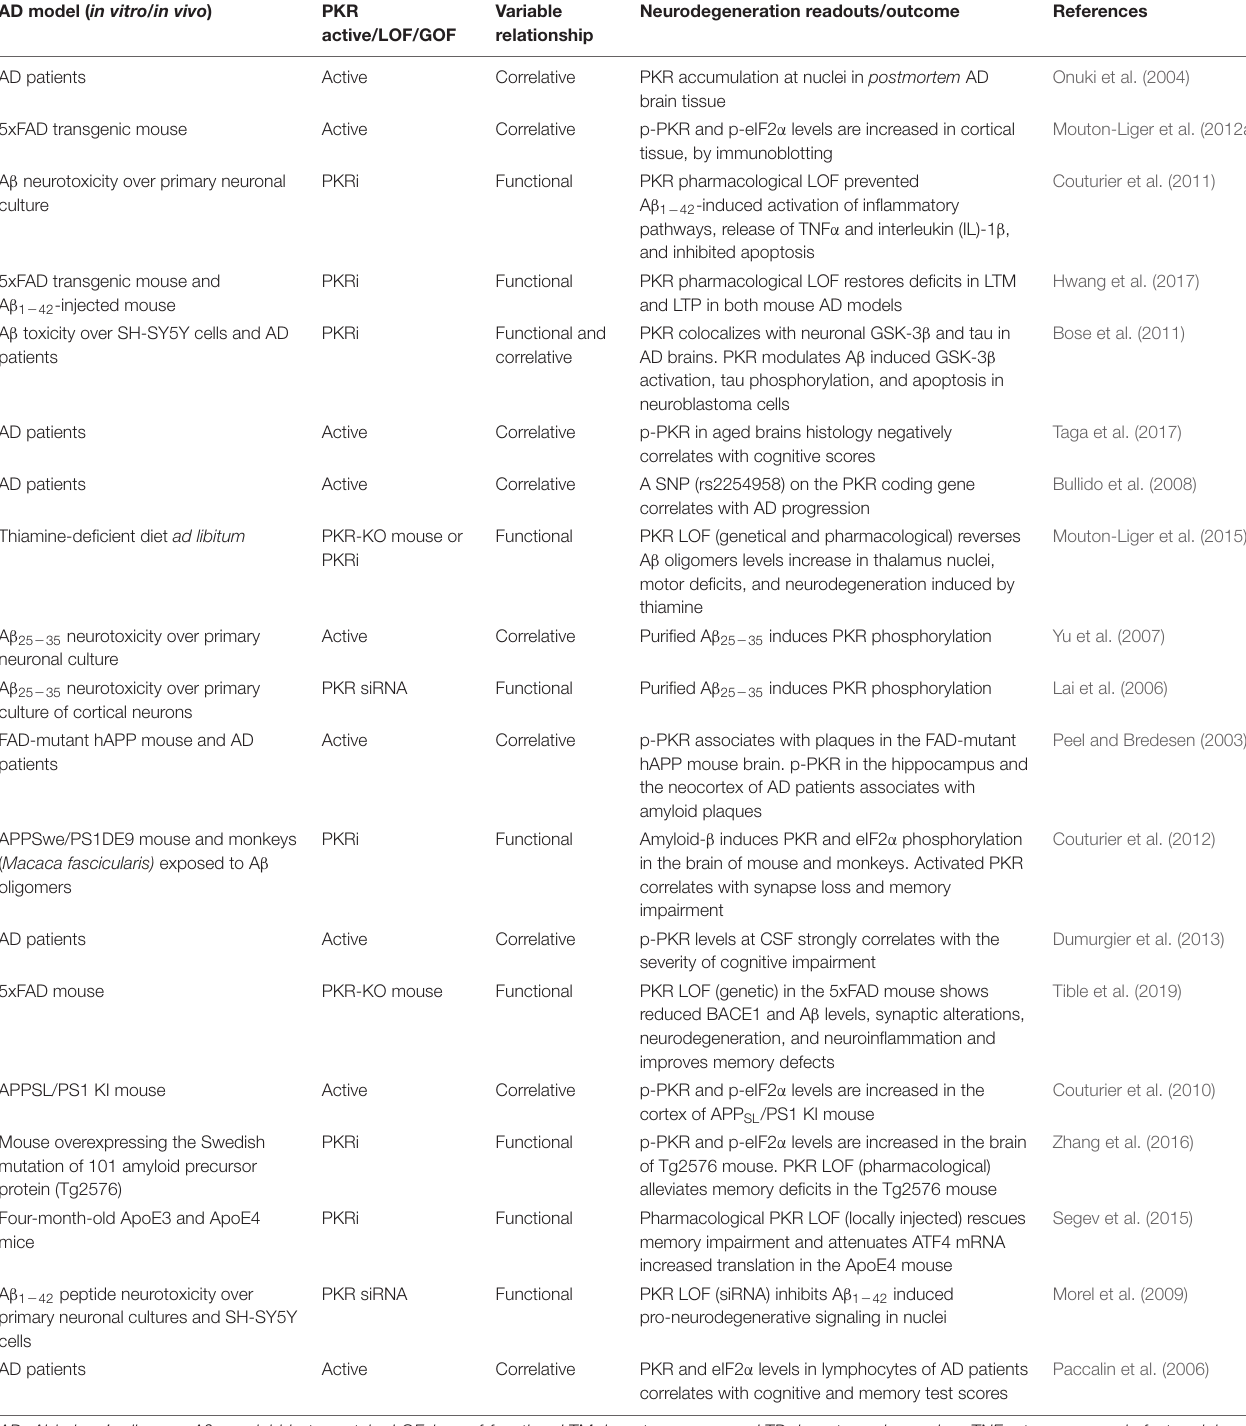
TABLE 1 | Studies involving protein kinase R (PKR) in Alzheimer’s